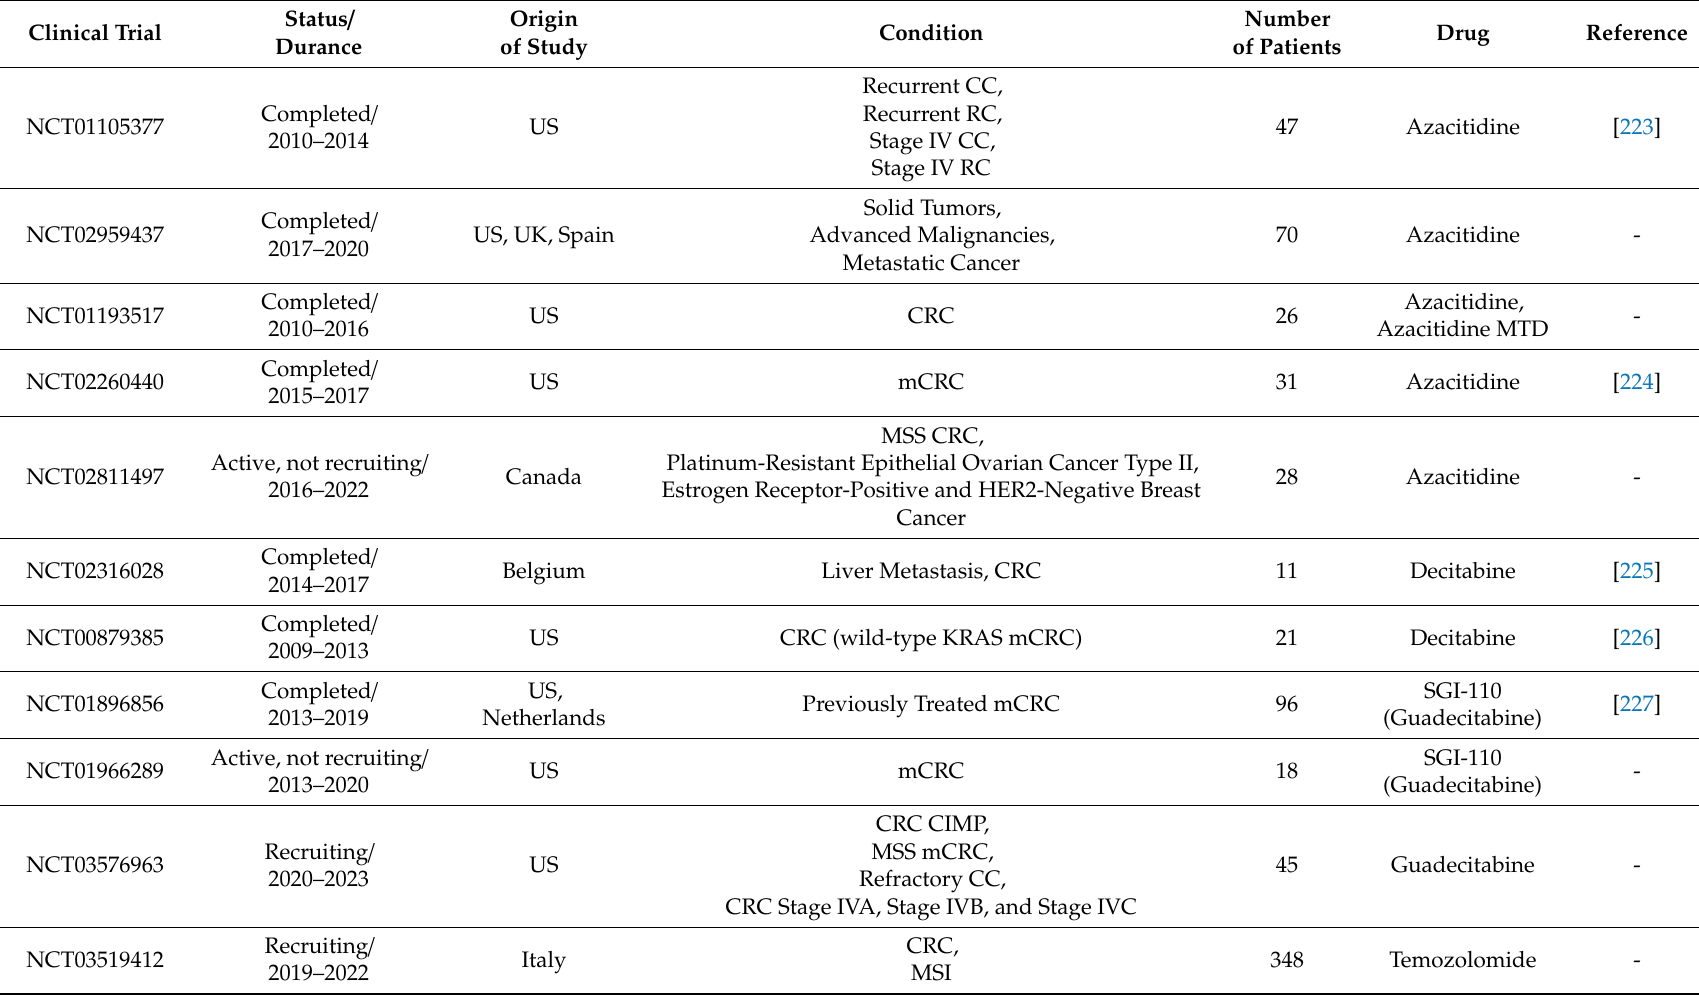
Table 3. Clinical trials on hypo- and hypermethylating chemotherapeutic drugs used in colorectal cancer treatment. Clinical